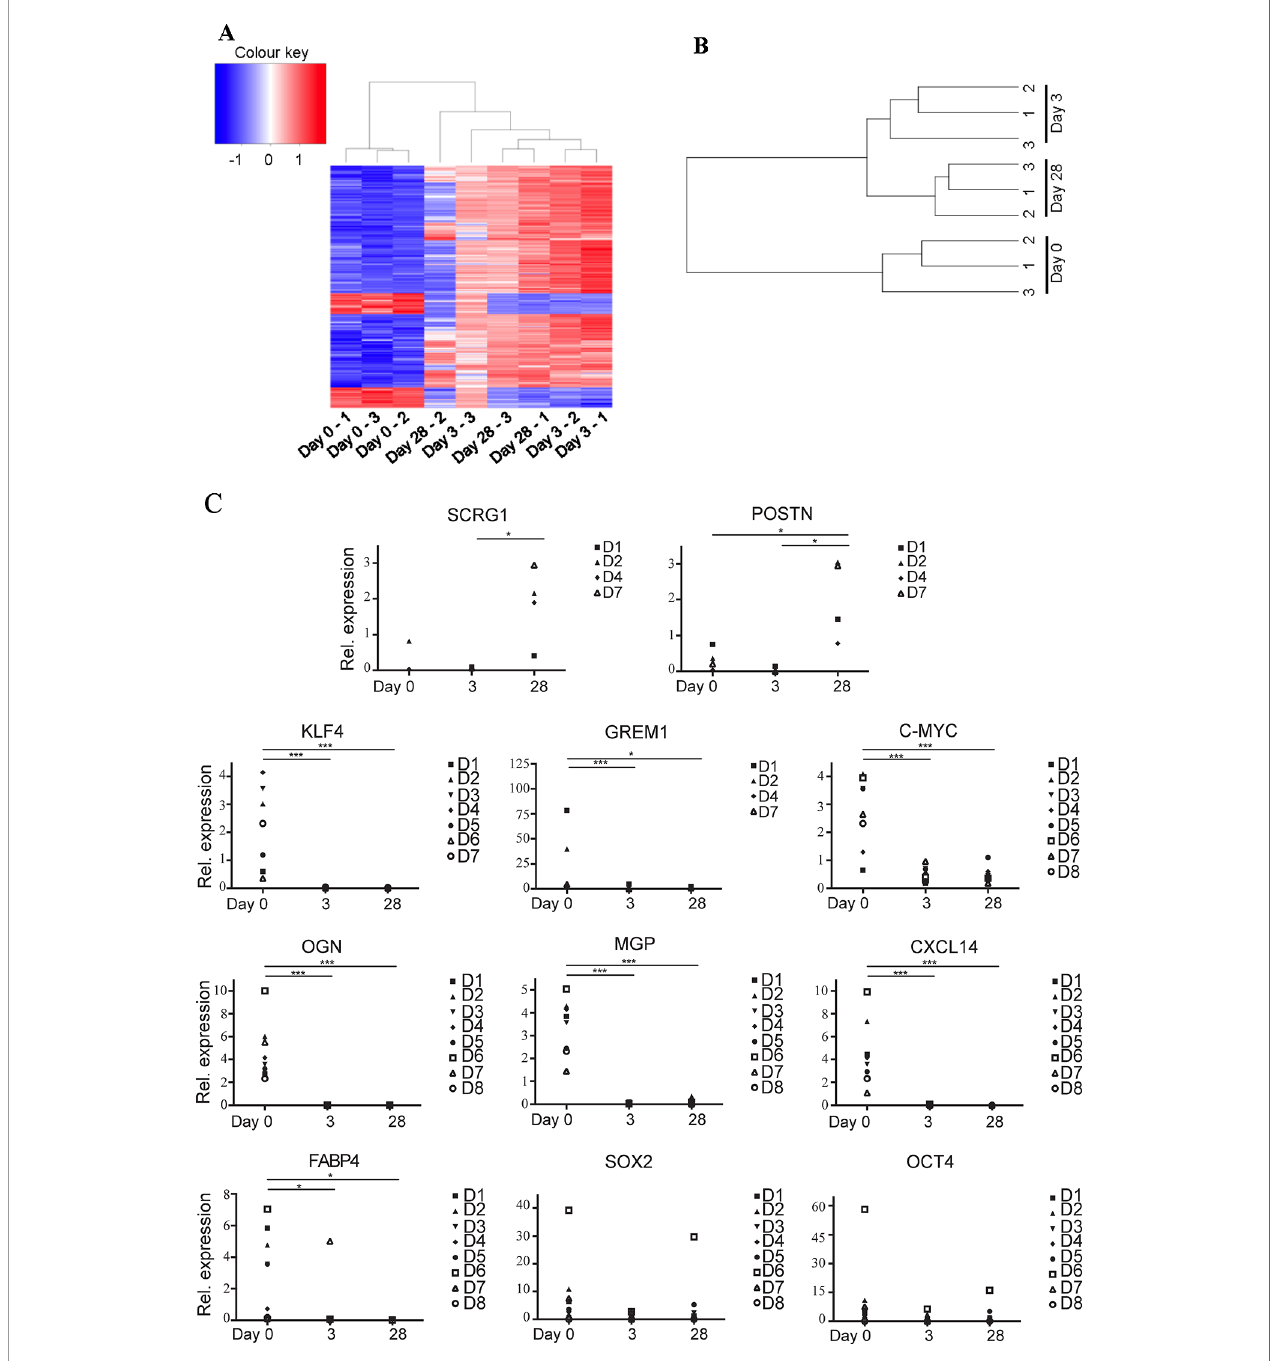
FIGURE 3 | Ex vivo MACS-derived adipose-derived stem cell (ASC) exhibit rapid and marked changes in gene expression when subjected to standard tissue culture conditions. MACS-derived ASC were subjected to standard tissue-culture conditions and microarray analysis was performed at day 0, day 3, or day 28 post sort. (A) A heatmap was generated using a list of all transcripts which exhibited a fold change >10 when microarray data was analyzed using the Affymetrix Transcript Analysis Console software. Blue represents downregulated genes and red upregulated genes from three donor samples (1 – 3) at day 0, day 3, or day 28 post sort. (B) Unsupervised clustering was performed using all transcripts detected in the microarray data when processed using robust microarray average (RMA). This was then plotted as a dendogram to pictorially represent the relationship between the three donor samples (1 – 3) at day 0, day 3, or day 28 post sort. (C) Real-time PCR was used to validate a subset of the microarray data (target genes SCRG1, POSTN, KLF4, GREM1, C-MYC, OGN, MGP, CXCL14, FABP4, SOX2, and OCT4 as indicated) in at least four, and a maximum of eight subsequent donors (D1 – D8). * denotes a p value of < 0.05, *** denotes a p value of <